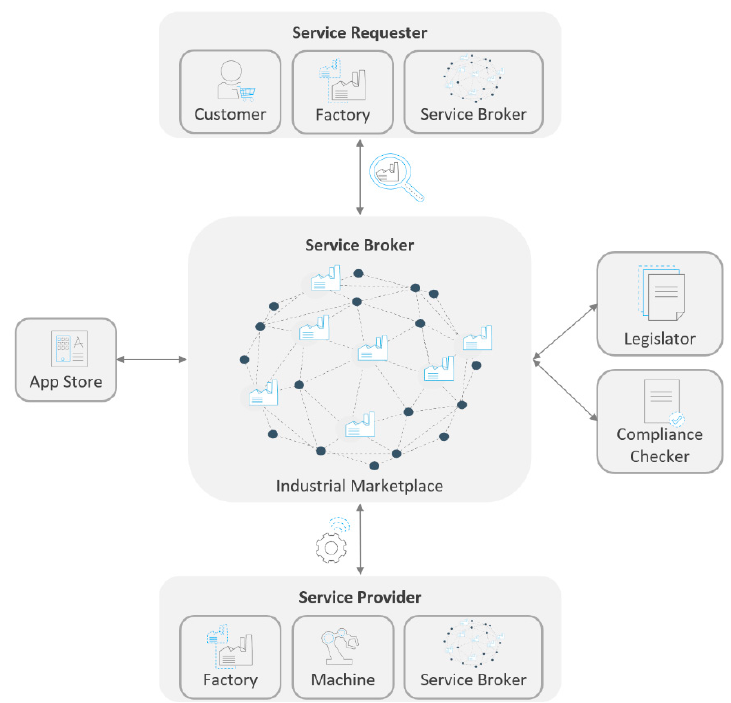
Figure 1. Stakeholders of industrial marketplaces and their interactions.